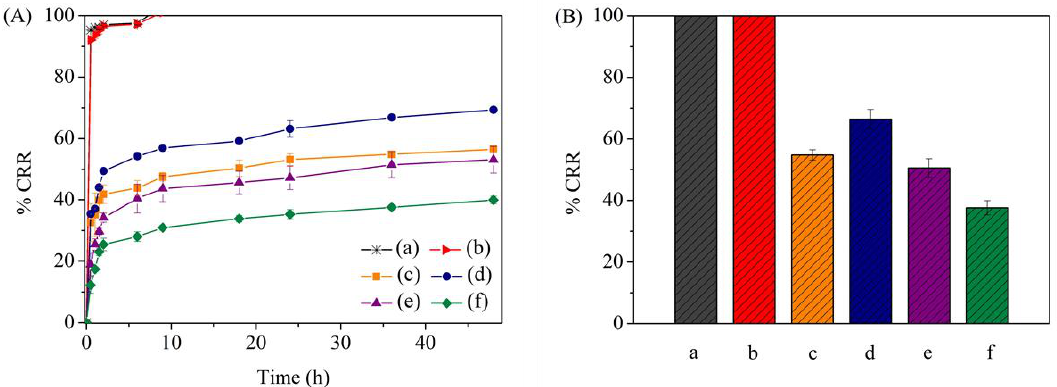
Figure 6. ( A ) Cumulative release ratio of ( a ) KH 2 PO 4 powder , ( b ) fertilizer 18-46-0, ( c ) PHBs-DI, ( d ) PHBs-pH = 5, ( e ) s-PHBs-DI, and ( f ) s-PHBs-pH = 5 in aqueous solution and ( B ) their plots of average phosphate release in the last 24